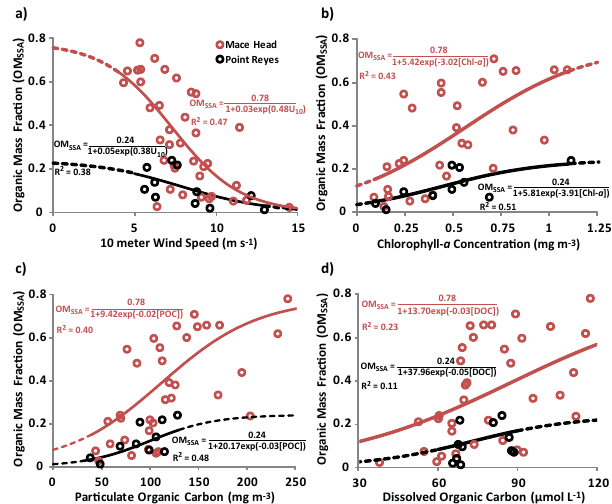
Fig. 2. Organic mass fraction of sea spray aerosol as a func- tion of (a) observed 10m wind speed ( U 10 ) and upwind averaged ocean concentrations of 8-day averaged (b) [Chl- a ], (c) [POC], and (d) [DOC] for Mace Head and Point Reyes. In Fig. 2b, four out- lier data points for Mace Head with [Chl- a ] > 1.25mgm − 3 have been excluded due to their occurrence during anomalously high chlorophyll- a concentrations in the region. The aerosol sizes mea- sured at Mace Head and Point Reyes were PM 1 . 5 and PM 2 . 5 , re- spectively, the solid lines show regression relationships for each station, and the dotted lines show an extrapolation of the regression